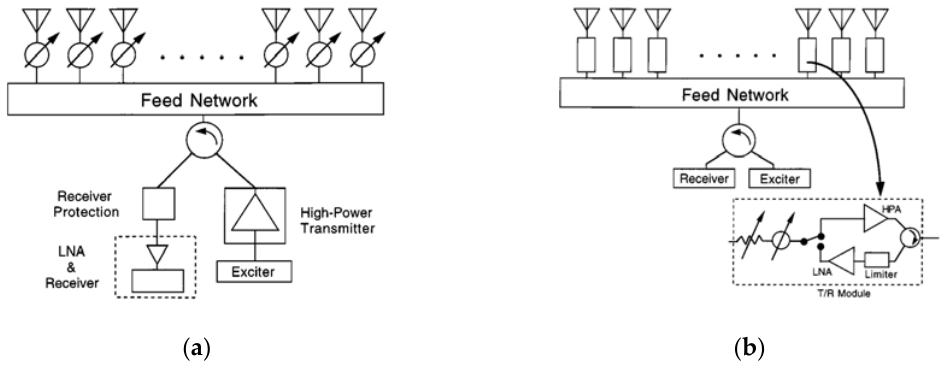
Figure 2. Basic architecture of ( a ) passive phased ‐ array architecture, and ( b ) active phased ‐ array architecture [1].